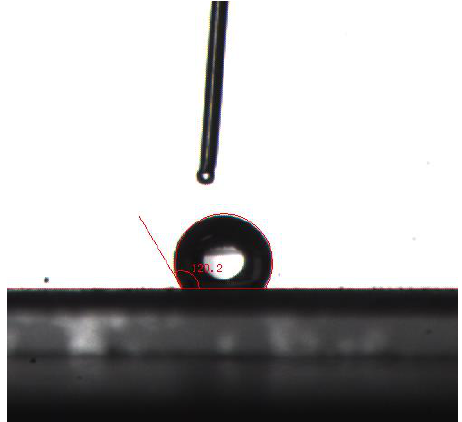
Figure 3. A contact angle image of Sample 5.